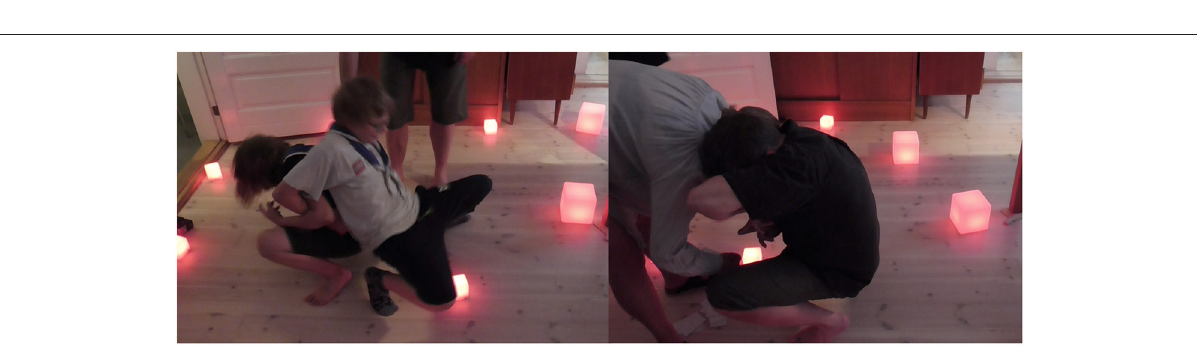
FIGURE 4 | Working together back to back, and ear to